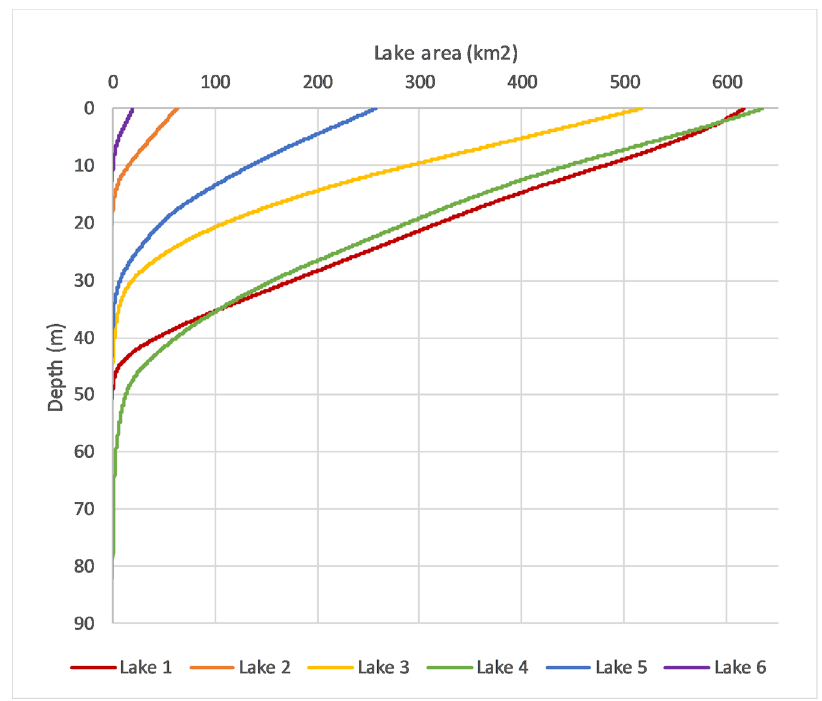
Figure 11. Hypsographic curves for each lake, relating lake area to depth (from AST14 DEMs).